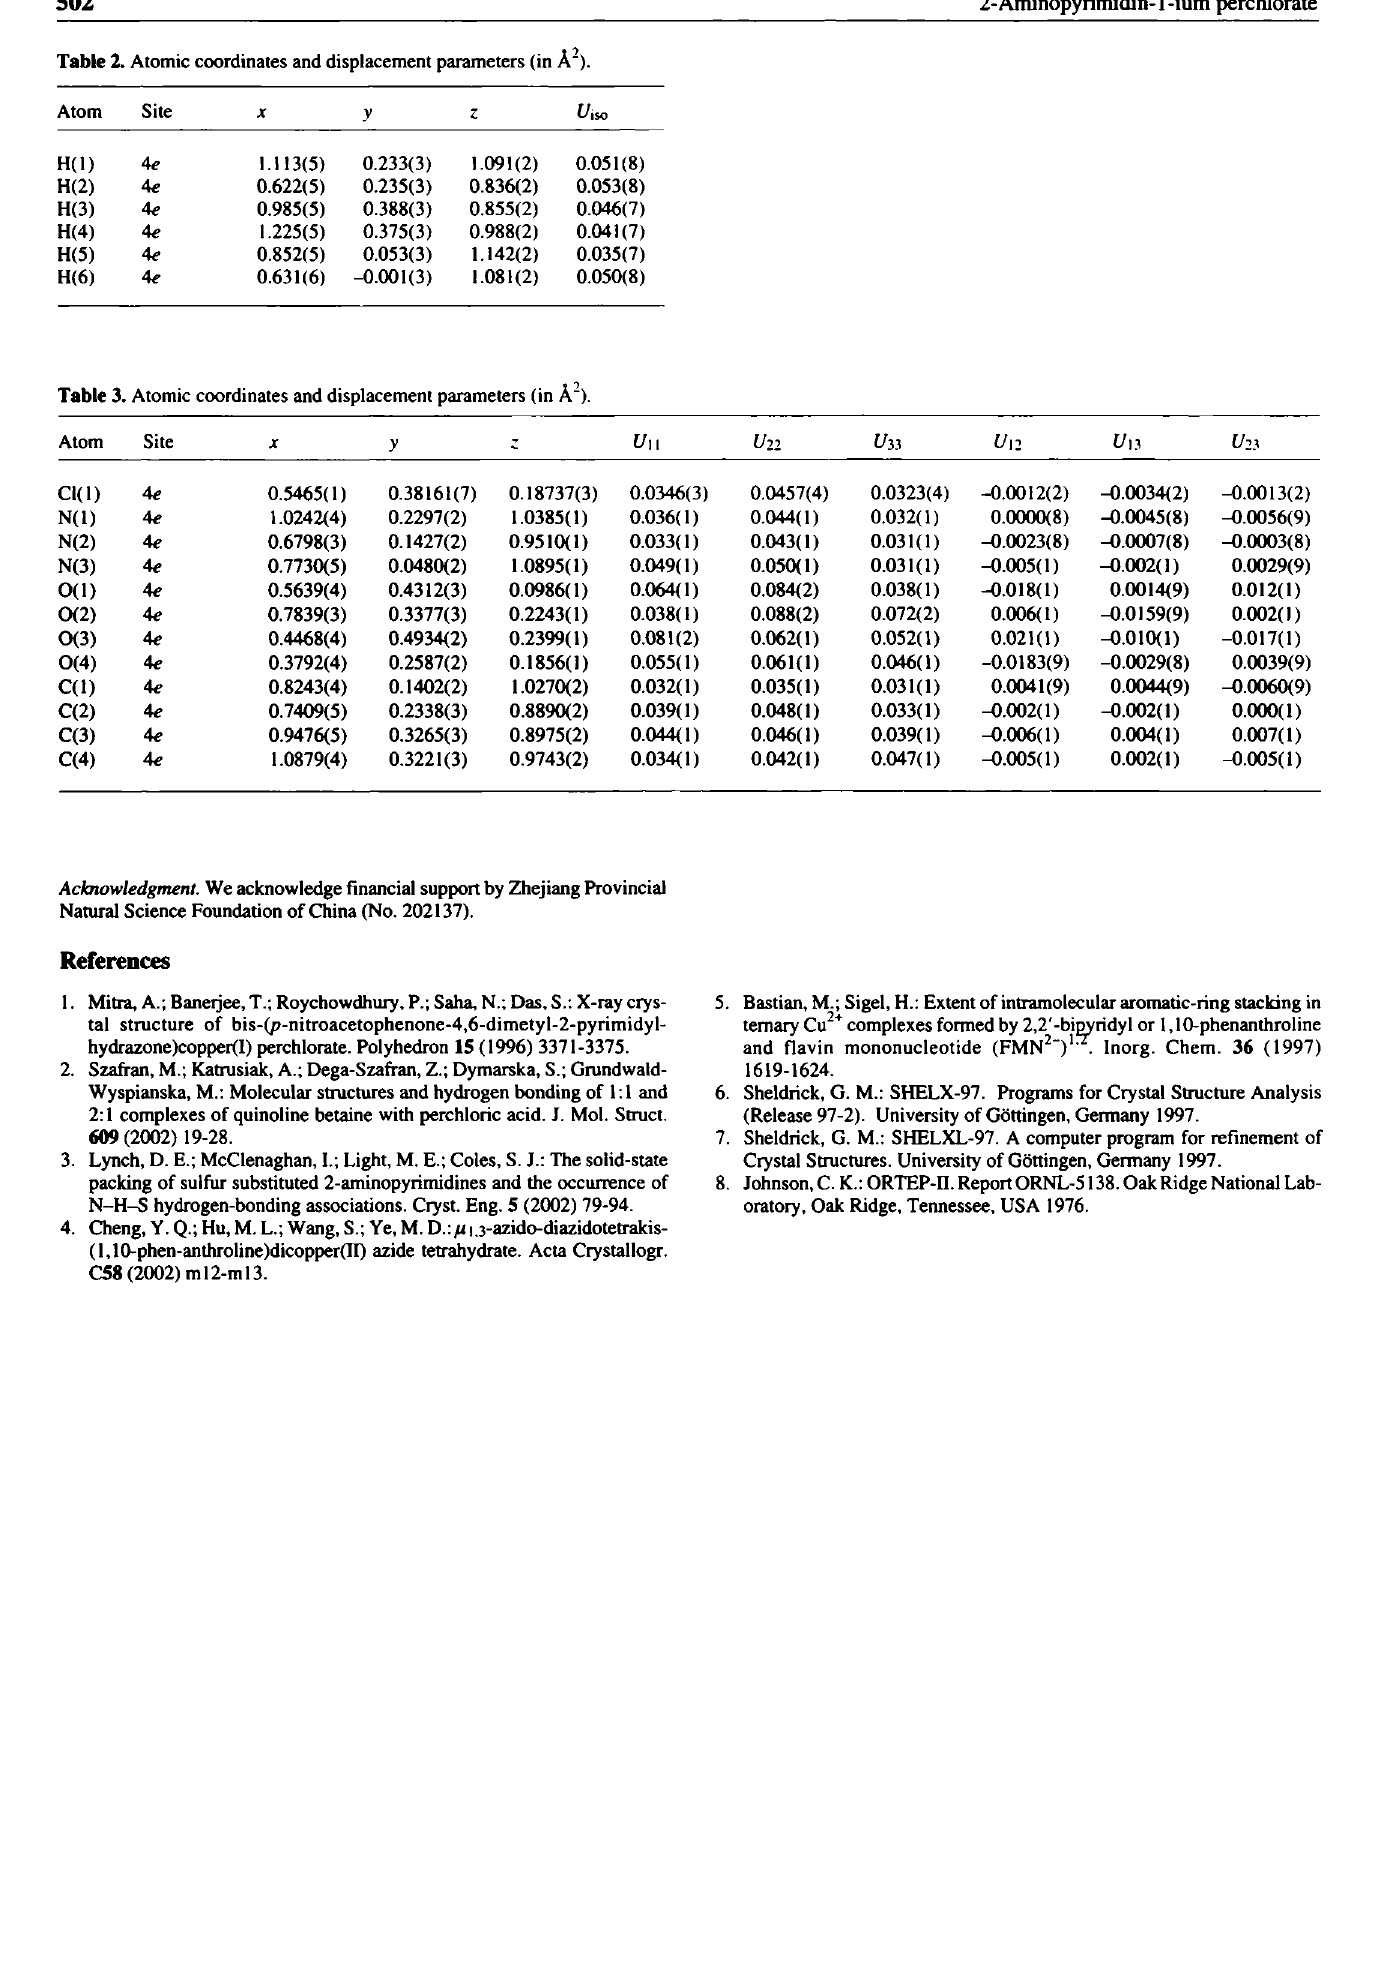
Table 3. Atomic coordinates and displacement parameters (in A 2